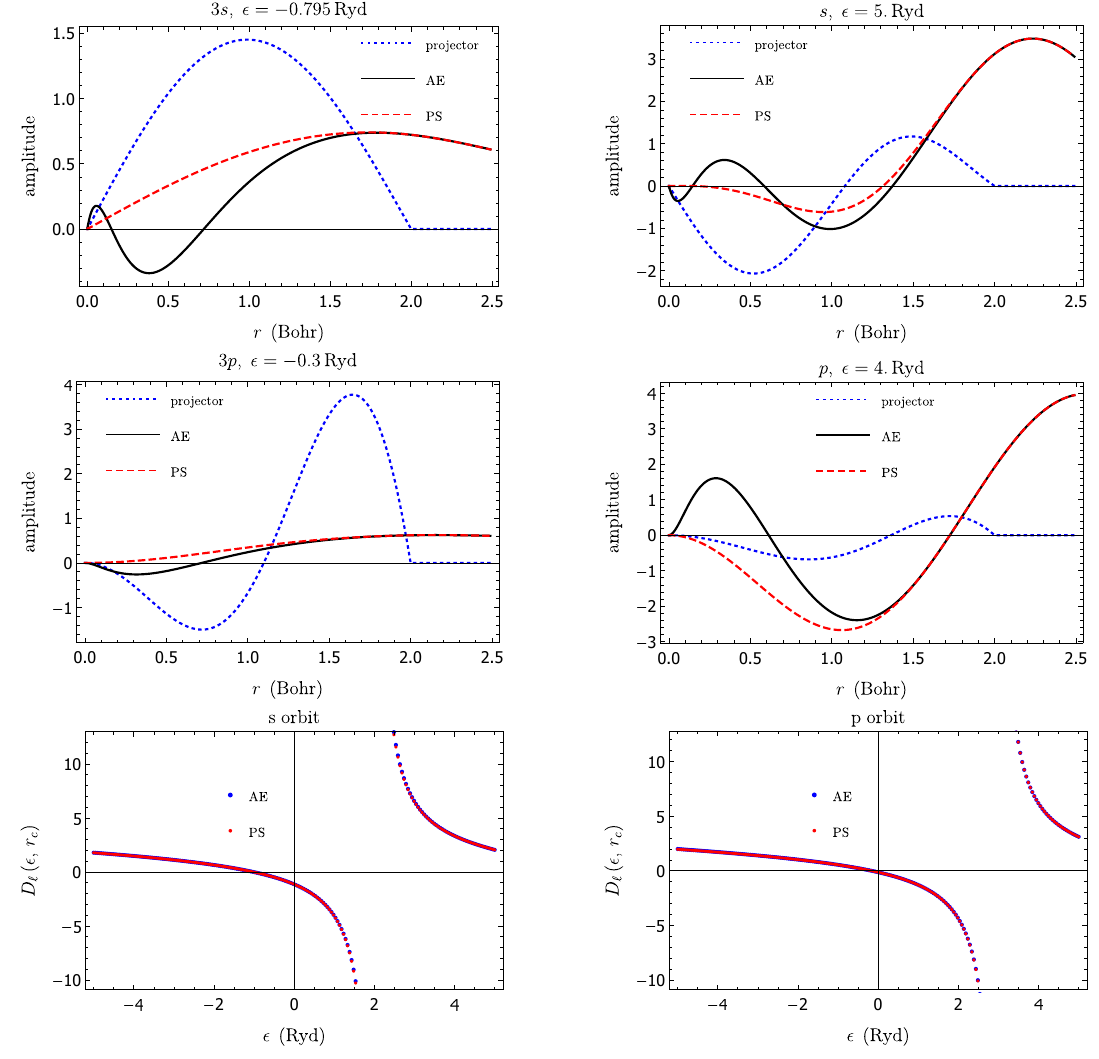
Figure 1 . Radial partial waves and energy derivatives for silicon. Shown in the first (second) row are two sets of AE ( black solid ), PS ( red dashed ) partial waves and projectors ( blue dotted ) for angular momentum ℓ = 0 (1), respectively, and in the third row the energy derivatives of the AE ( blue ) and PS ( red ) partial waves for ℓ = 0 (1) are also presented. See text for